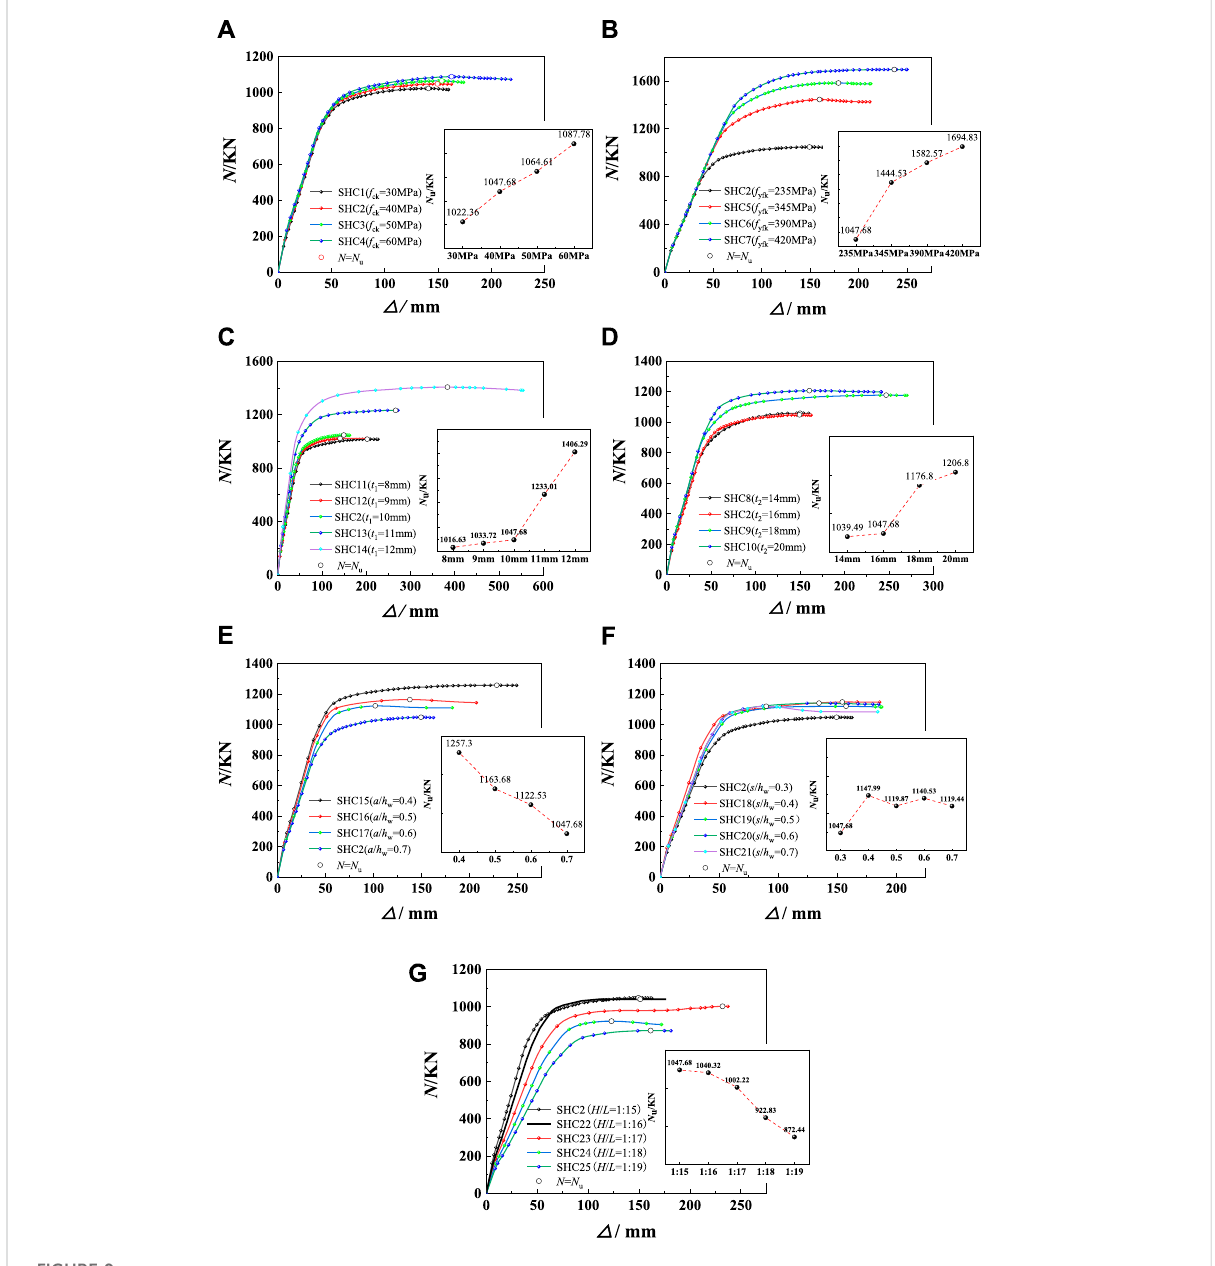
FIGURE 9 Comparisonsofload-displacementcurvesfor25SHC. (A) SHCwithdifferent f ck (B) SHCwithdifferent f yfk (C) SHCwithdifferent t 1 (D) SHCwith different t 2 (E) SHC with different a / h w (F) SHC with different s / h w (G) SHC with different H / L